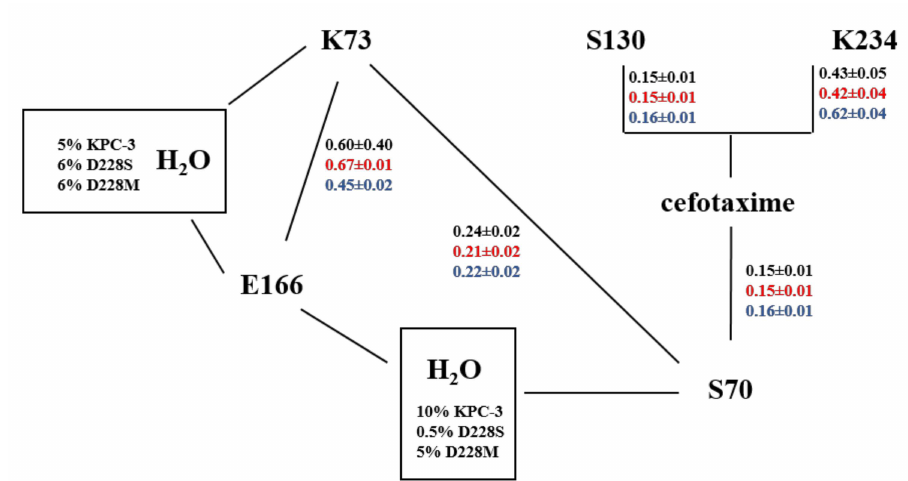
Figure 5. Average minimum distances and related standard deviations (in nm) between active-site residues and the Substrate. In black, red and blue we report the results for KPC-3, D228S and D228M, respectively. The ‘minimum distance’ indicates the smallest distance between all the couples of atoms between the interacting species. In the boxes, we also report the probability of finding one water molecule acting as a bridge between two di ff erent